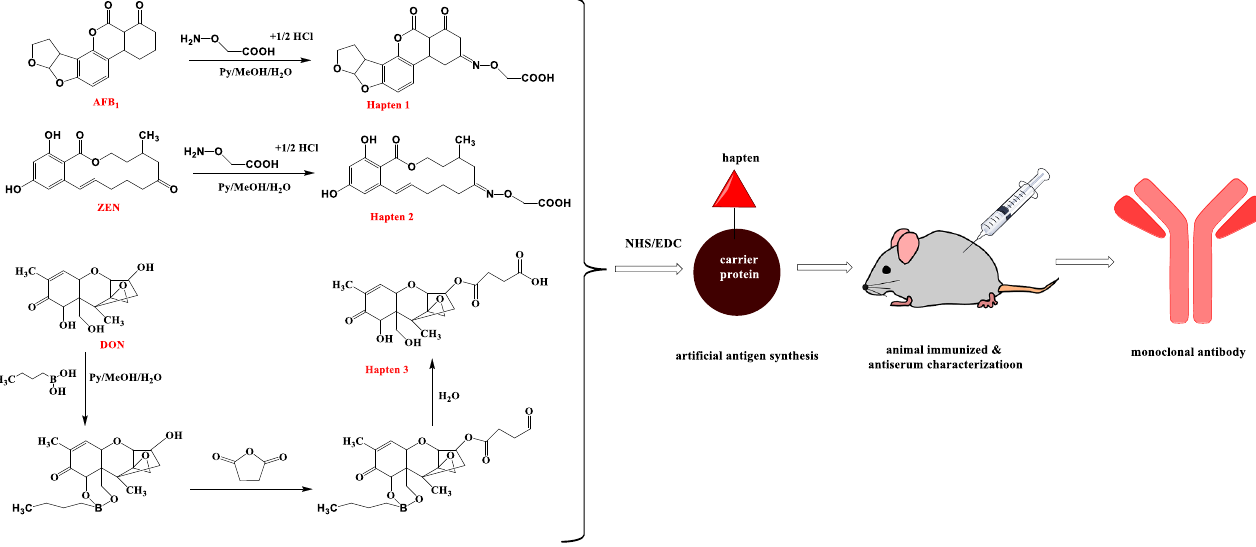
Figure 1. The schematic of developed MAb for AFB1, ZEN, and DON. Hapten 1, Hapten 2,